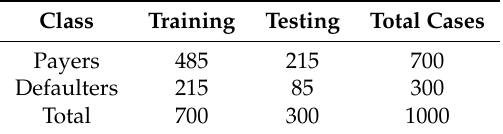
Table 1. Distribution of observations in the German Credit